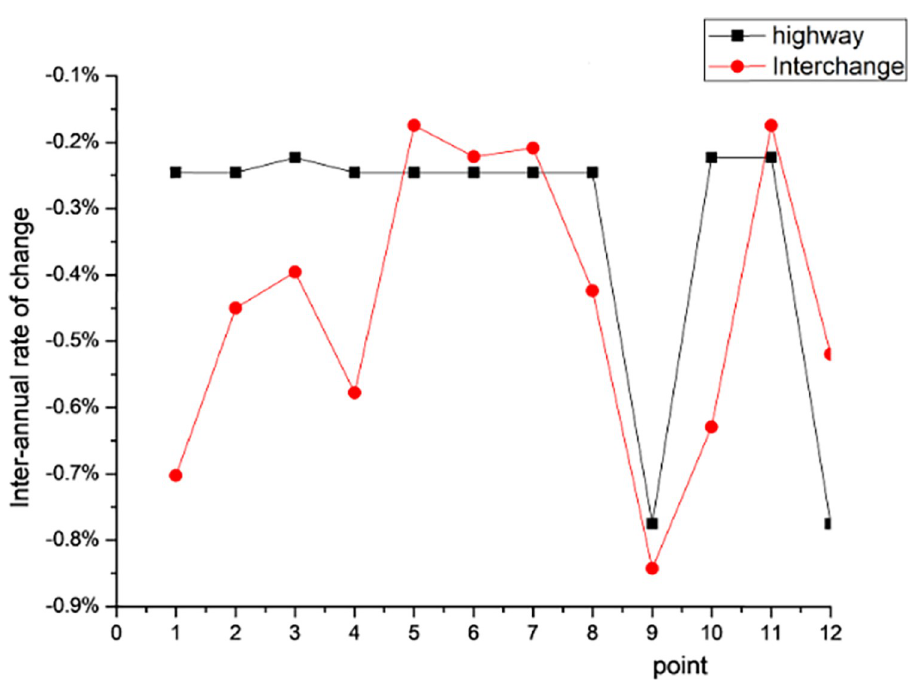
Fig 17. Interannual VSWI change rate